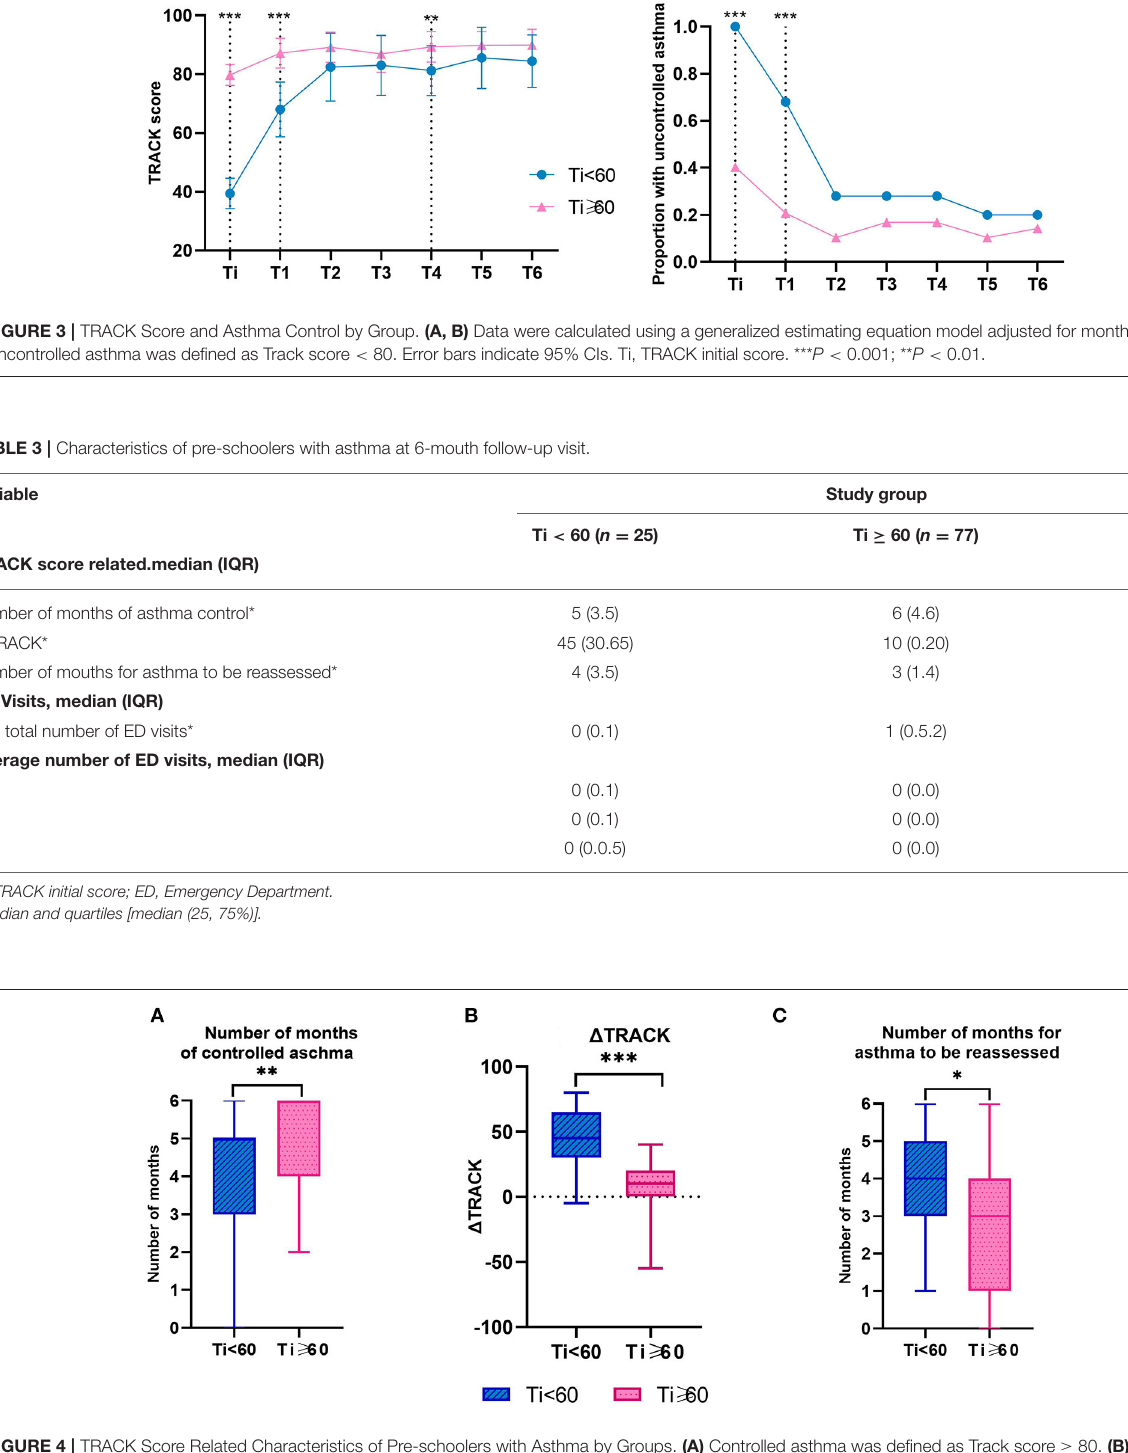
FIGURE 4 | TRACK Score Related Characteristics of Pre-schoolers with Asthma by Groups. (A) Controlled asthma was defined as Track score ≥ 80. (B) 1 TRACK was defined as T6 minus Ti. (C) Asthma should be reassessed when the TRACK score changes by more than 10 points. Ti, TRACK initial score. *** P < 0.001; ** P < 0.01; * P <